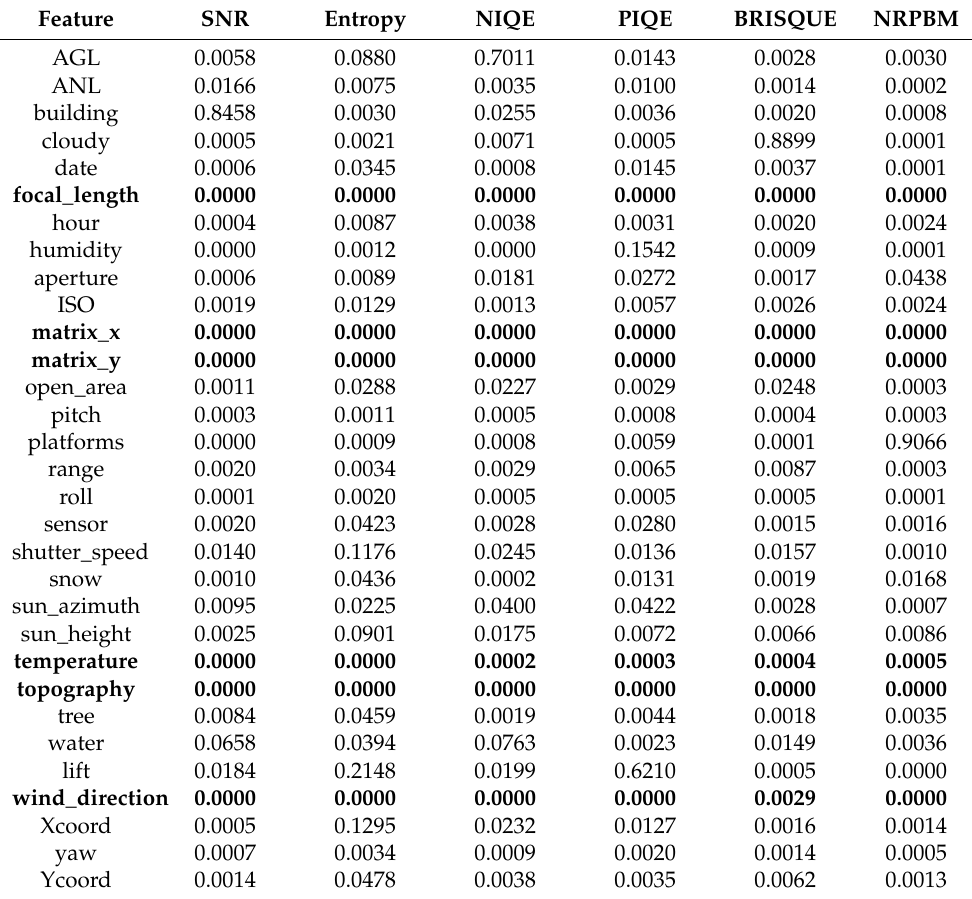
Table 3. Importance of characteristics for Case